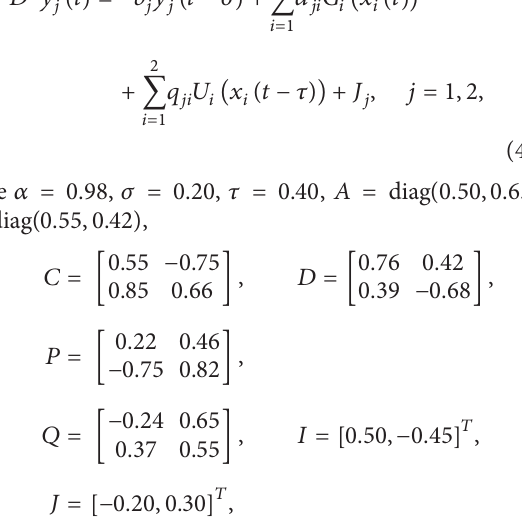
(−6.5, −7.0, 7.5, 8.0) 𝑇 , and case 5 with the initial values , 𝑥 , 𝑦 , 𝑦 ) 𝑇 = (4.0, 2.0, 1.5, 1.0) 𝑇 . The time responses of (𝑥 1 2 1 2 state variables are shown in Figure